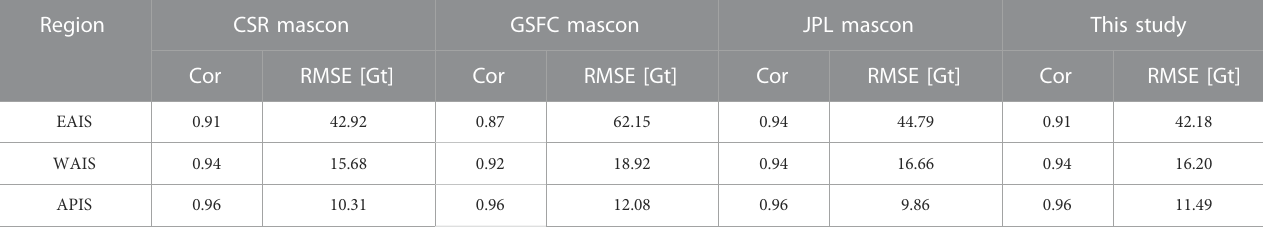
TABLE 7 Correlation coef fi cients and RMSE of detrended and smoothed mass change from four mascon solutions and RACMO. Region CSR mascon GSFC mascon JPL mascon This